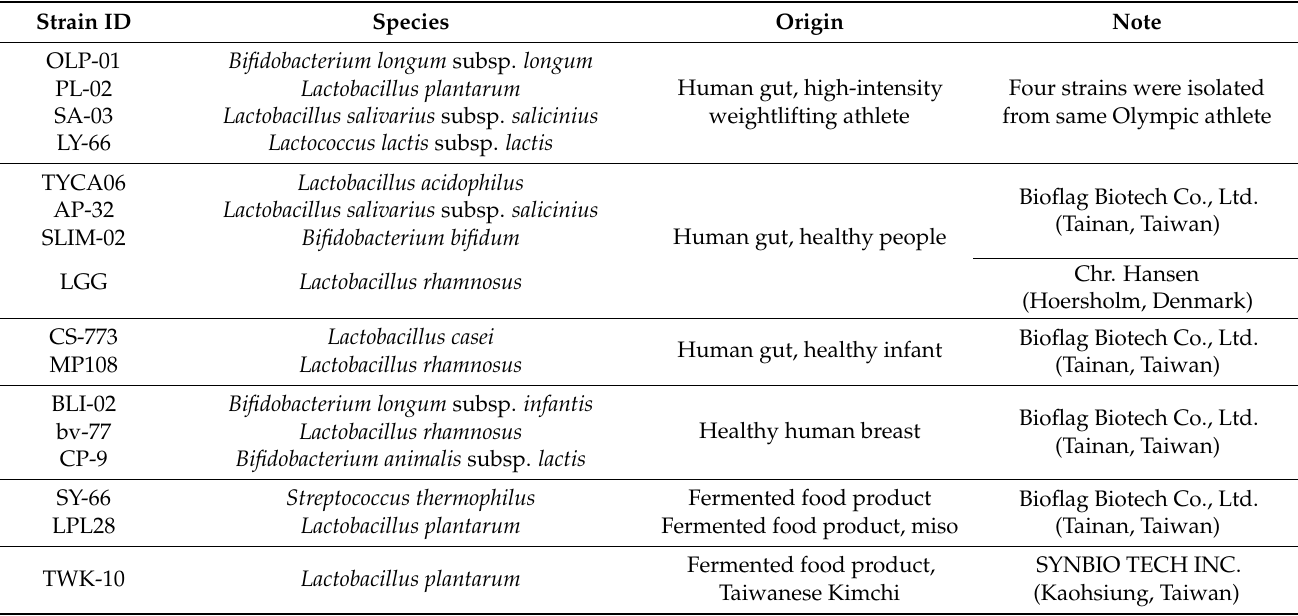
Table 1. Origins of probiotic